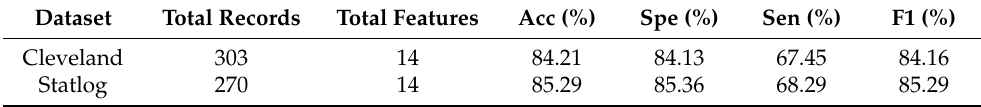
Table 3. Performance of proposed model without feature selection.